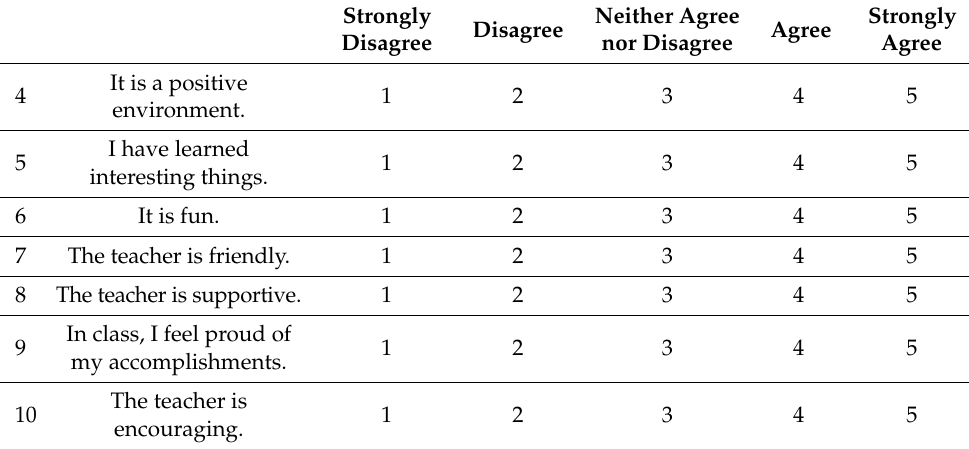
Table A2. Here are some statements about teamwork. To what extent do you agree with